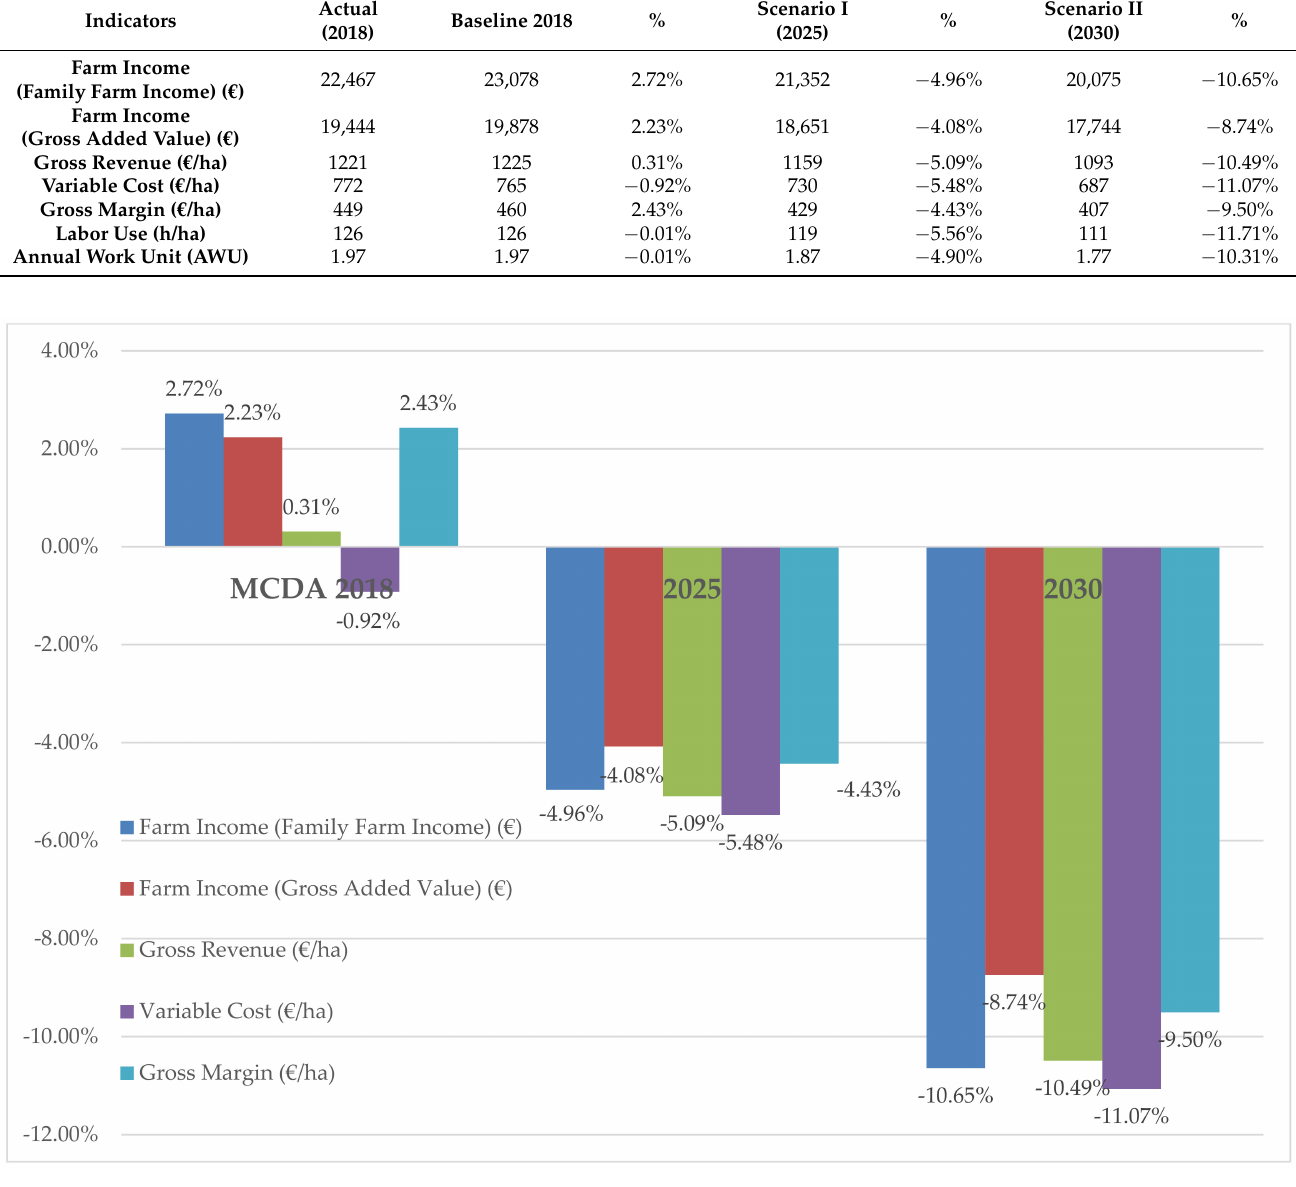
Figure 4. Economic indicators